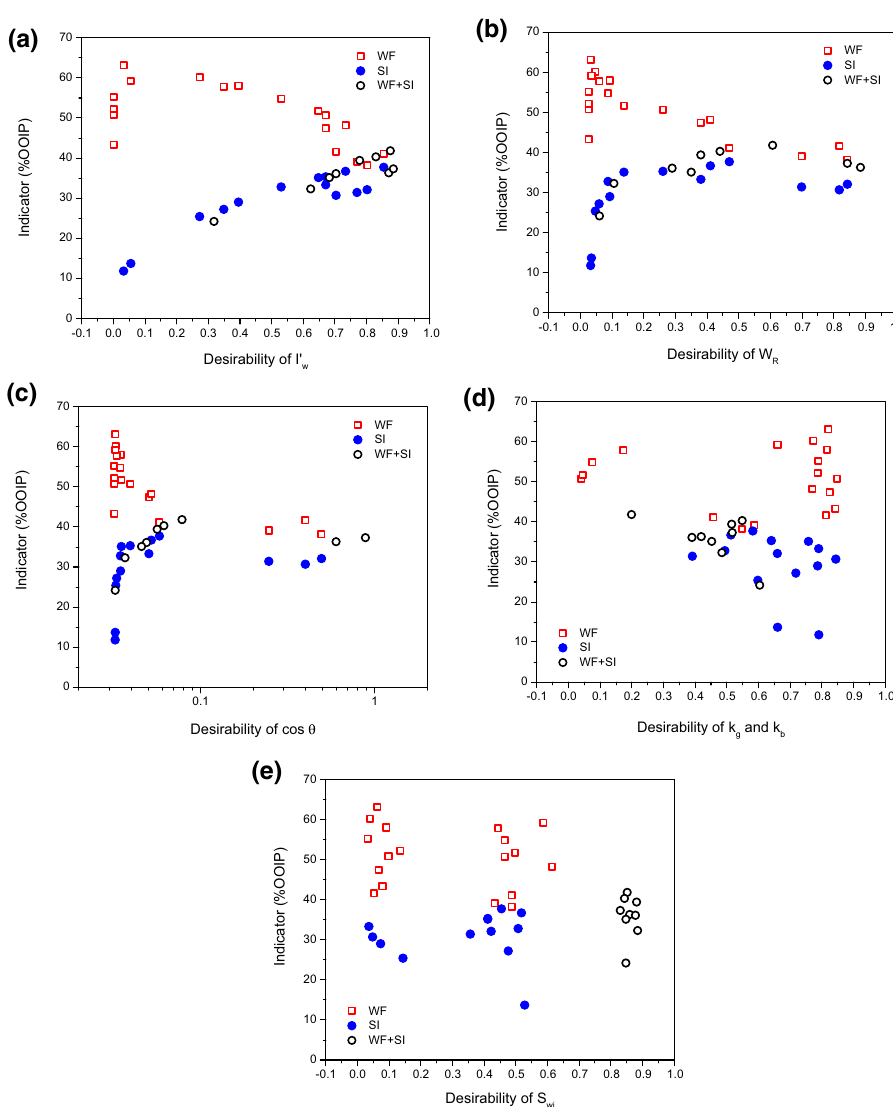
Fig. 7 Individual desirability ( d i ) of a modified Amott index ( I ′ w ), b relative pseudowork of imbibition ( W R ), c cosine of aqueous contact angle (cos θ ), d gas and brine permeabilities ( k g and k b ) and e initial water saturation ( S wi ) to the oil recov- ery (%OOIP) as an assessing indicator. The data are shown in three set of recovery methods including waterflooding (WF: hallow square), spontaneous imbibition (SI: solid circle) and waterflooding after spontaneous imbibition completed (WF + SI: hallow